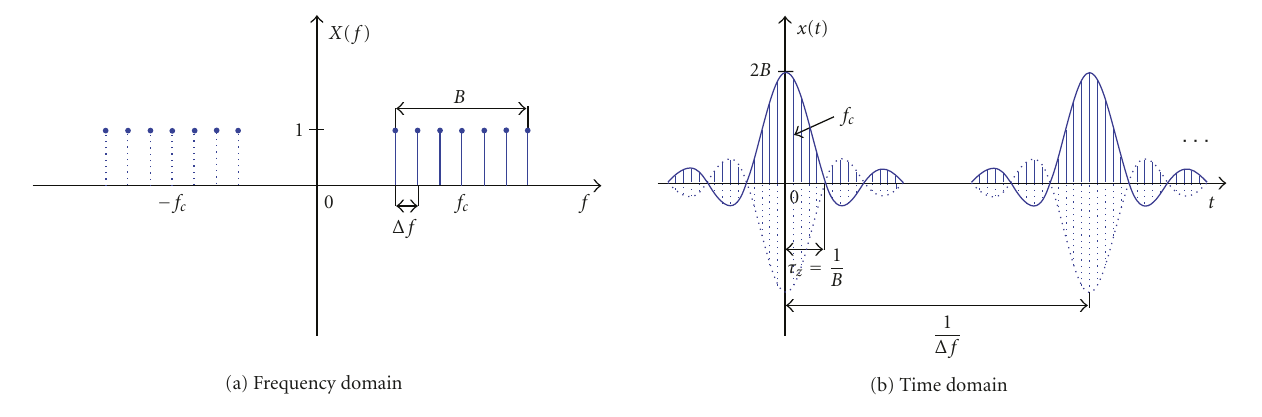
Figure 2: The signal emitted at the